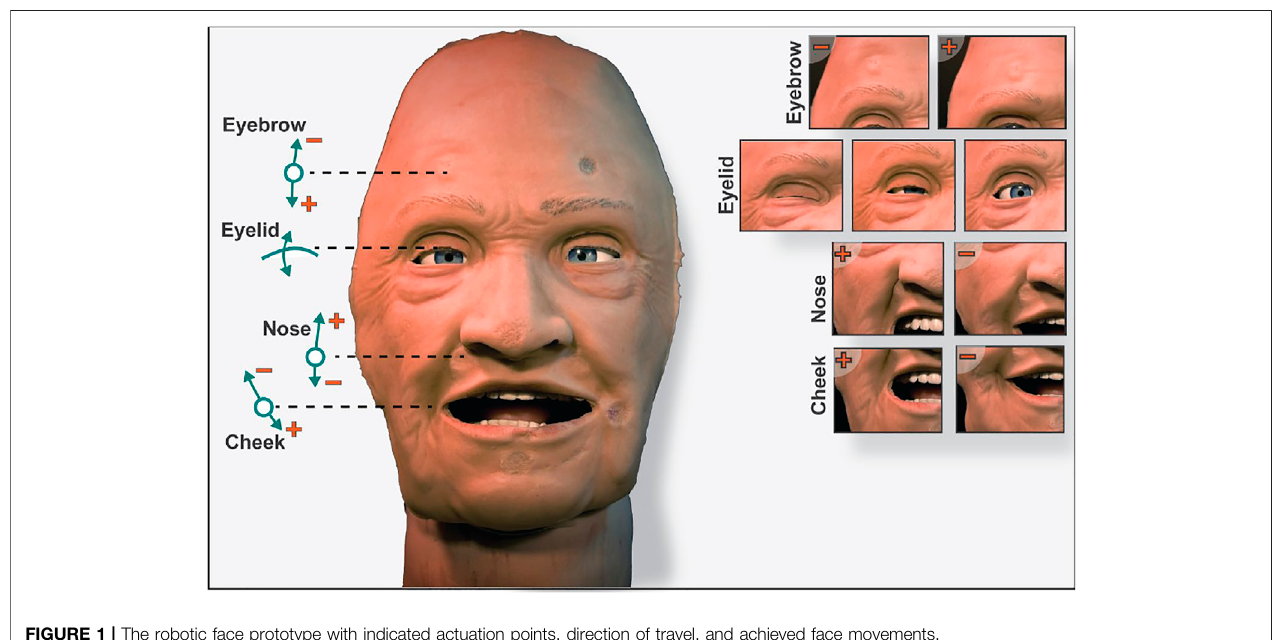
FIGURE 1 | The robotic face prototype with indicated actuation points, direction of travel, and achieved face movements.